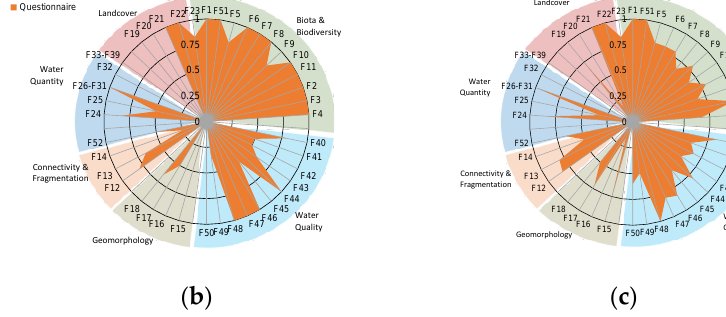
Figure 4. Spider diagram for cascade GZBP and TGP, ( a ) EEM result of new developed cascade GZBP and TGP, ( b ) SBQ result of new developed cascade GZBP and TGP, ( c ) SBQ result of existing cascade GZBP and TGP.